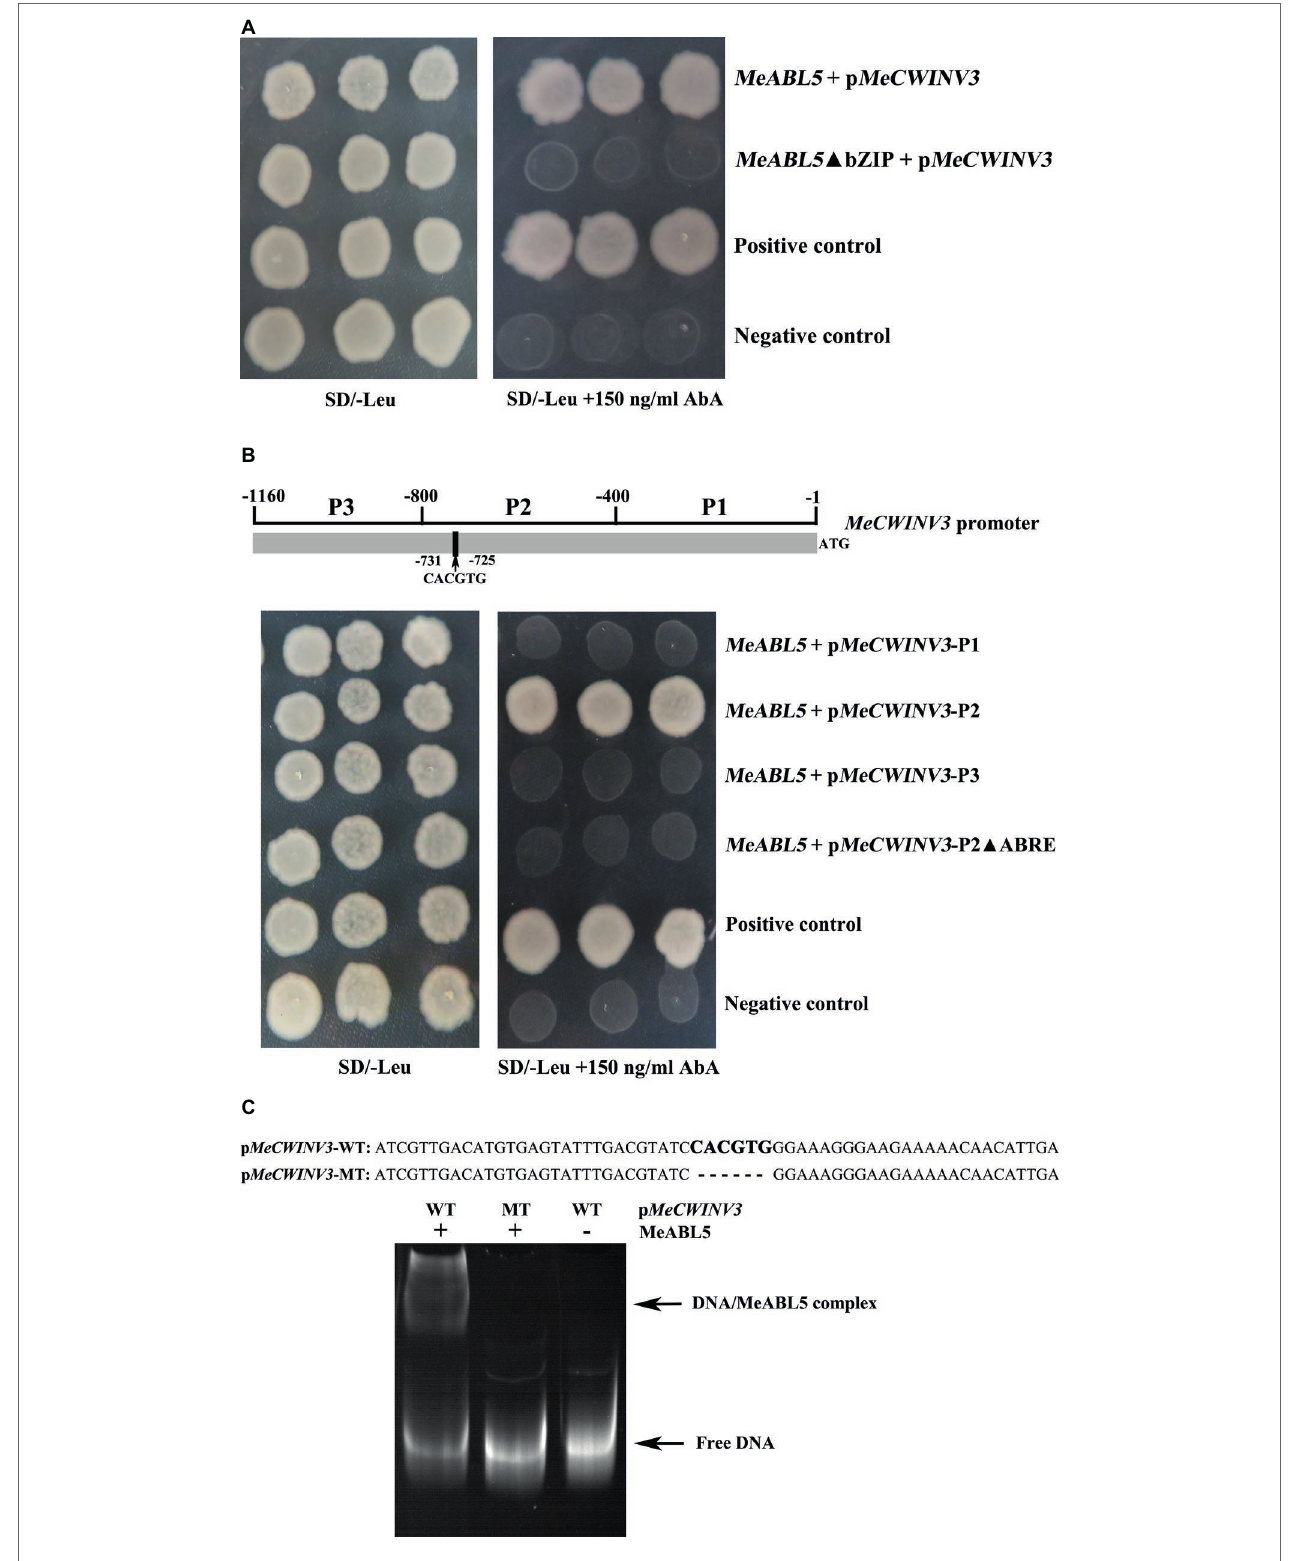
FIGURE 7 | MeABL5 binds to the ABRE cis-element in the MeCWINV3 promoter. (A) Yeast-one hybrid (Y1H) assay of the core binding site in MeABL5 binds to the MeCWINV3 promoter. The full-length MeABL5 and the bZIP domain deletion (MeABL5ΔbZIP) sequences were inserted into the pGADT7 vector. Yeast cells